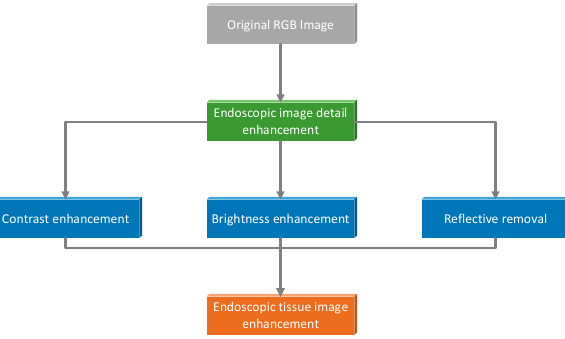
Figure 1. Algorithm flowchart.